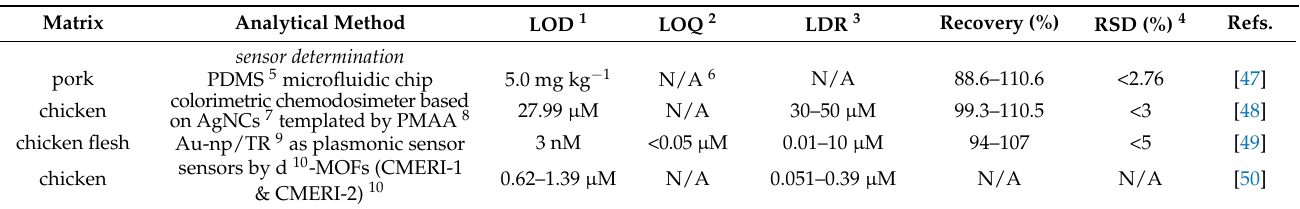
Table 2. Analytical performance of sensing and no-sensing determinations applied to meat matrix. The term “N/A” means the information is absent in the